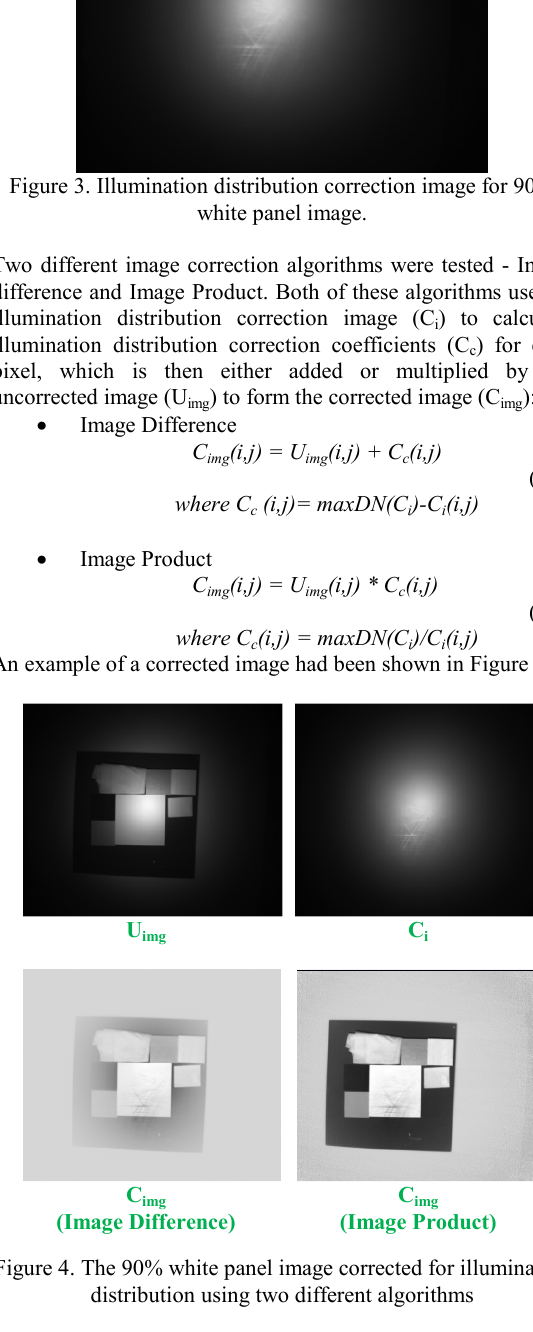
correct any data for the purpose of this research. The Results section of this paper contains results obtained using the Image Product